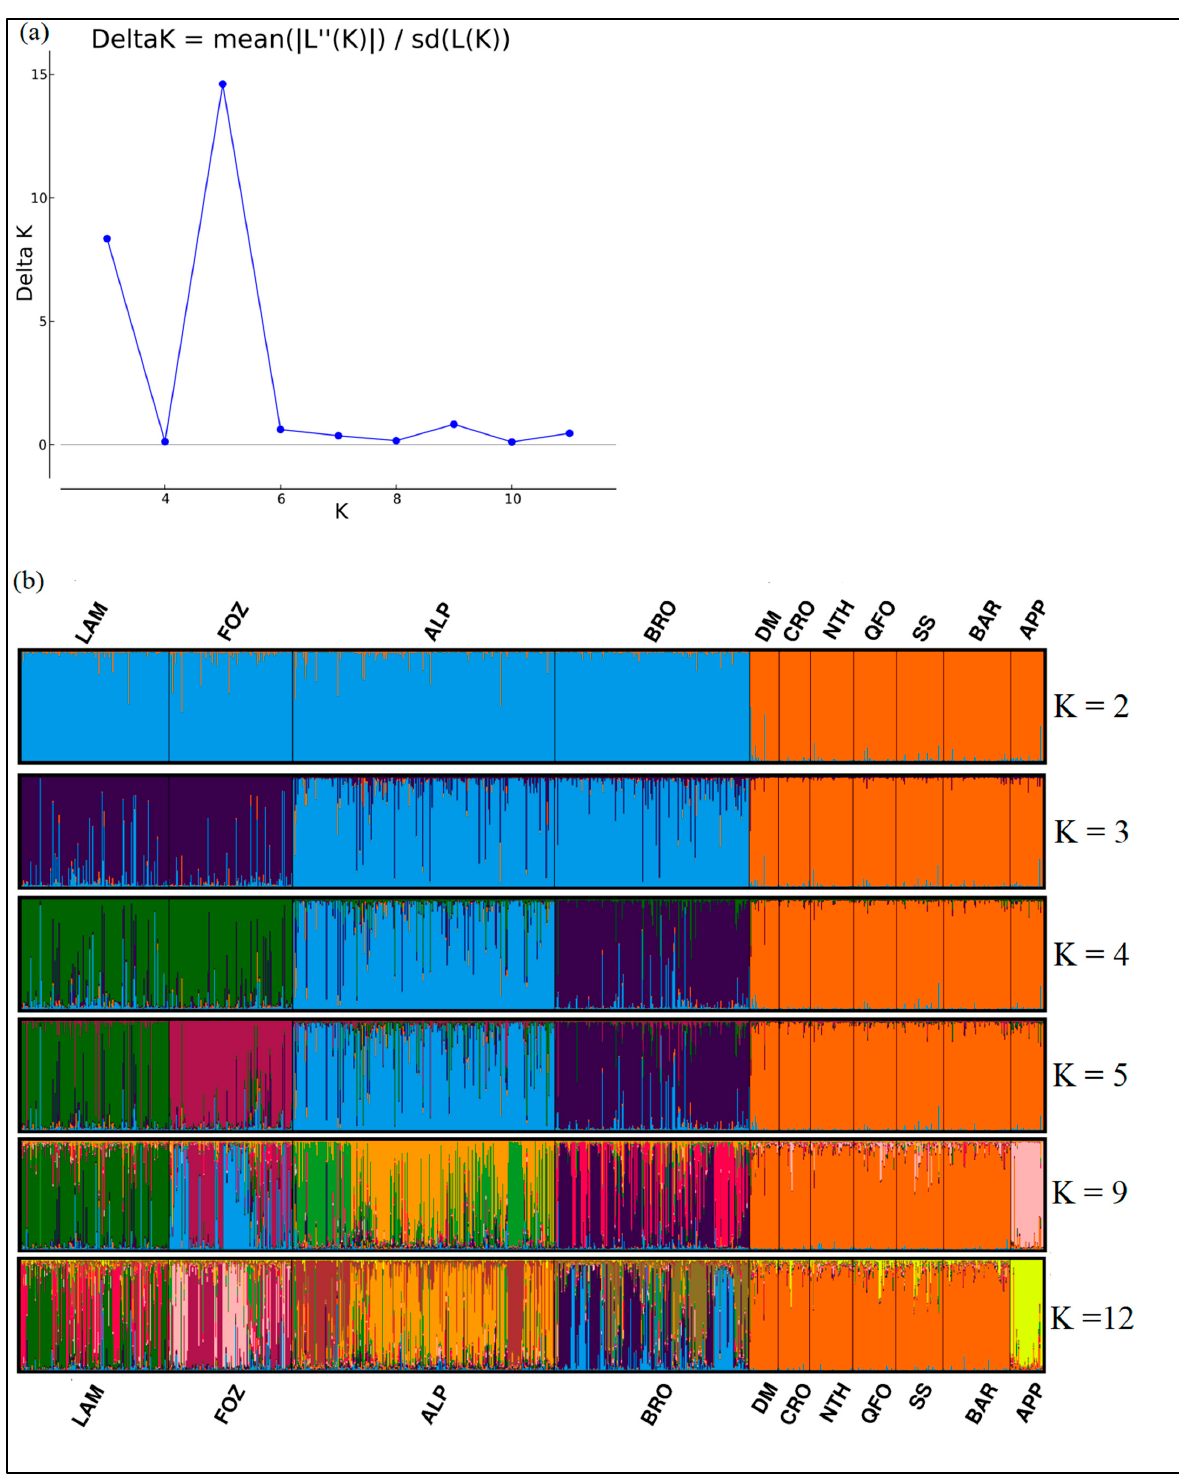
Figure 3. ( a ) Delta K values obtained with the STRUCTURE HARVESTER. ( b ) Estimated population structure of the analyzed breeds represented as bar plot depicting individual membership proportions for each cluster; Venetian breeds: Alpagota (ALP), Brogna (BRO), Foza (FOZ) and Lamon (LAM); Central Italian breed: Appenninica (APP); Tunisian breeds: Barbarine (BAR), Sicilo-Sarde (SS), Queue Fine de l’Ouest (QFO), Noire de Thibar (NTH), cross bred BAR × QFO (CRO), D’man